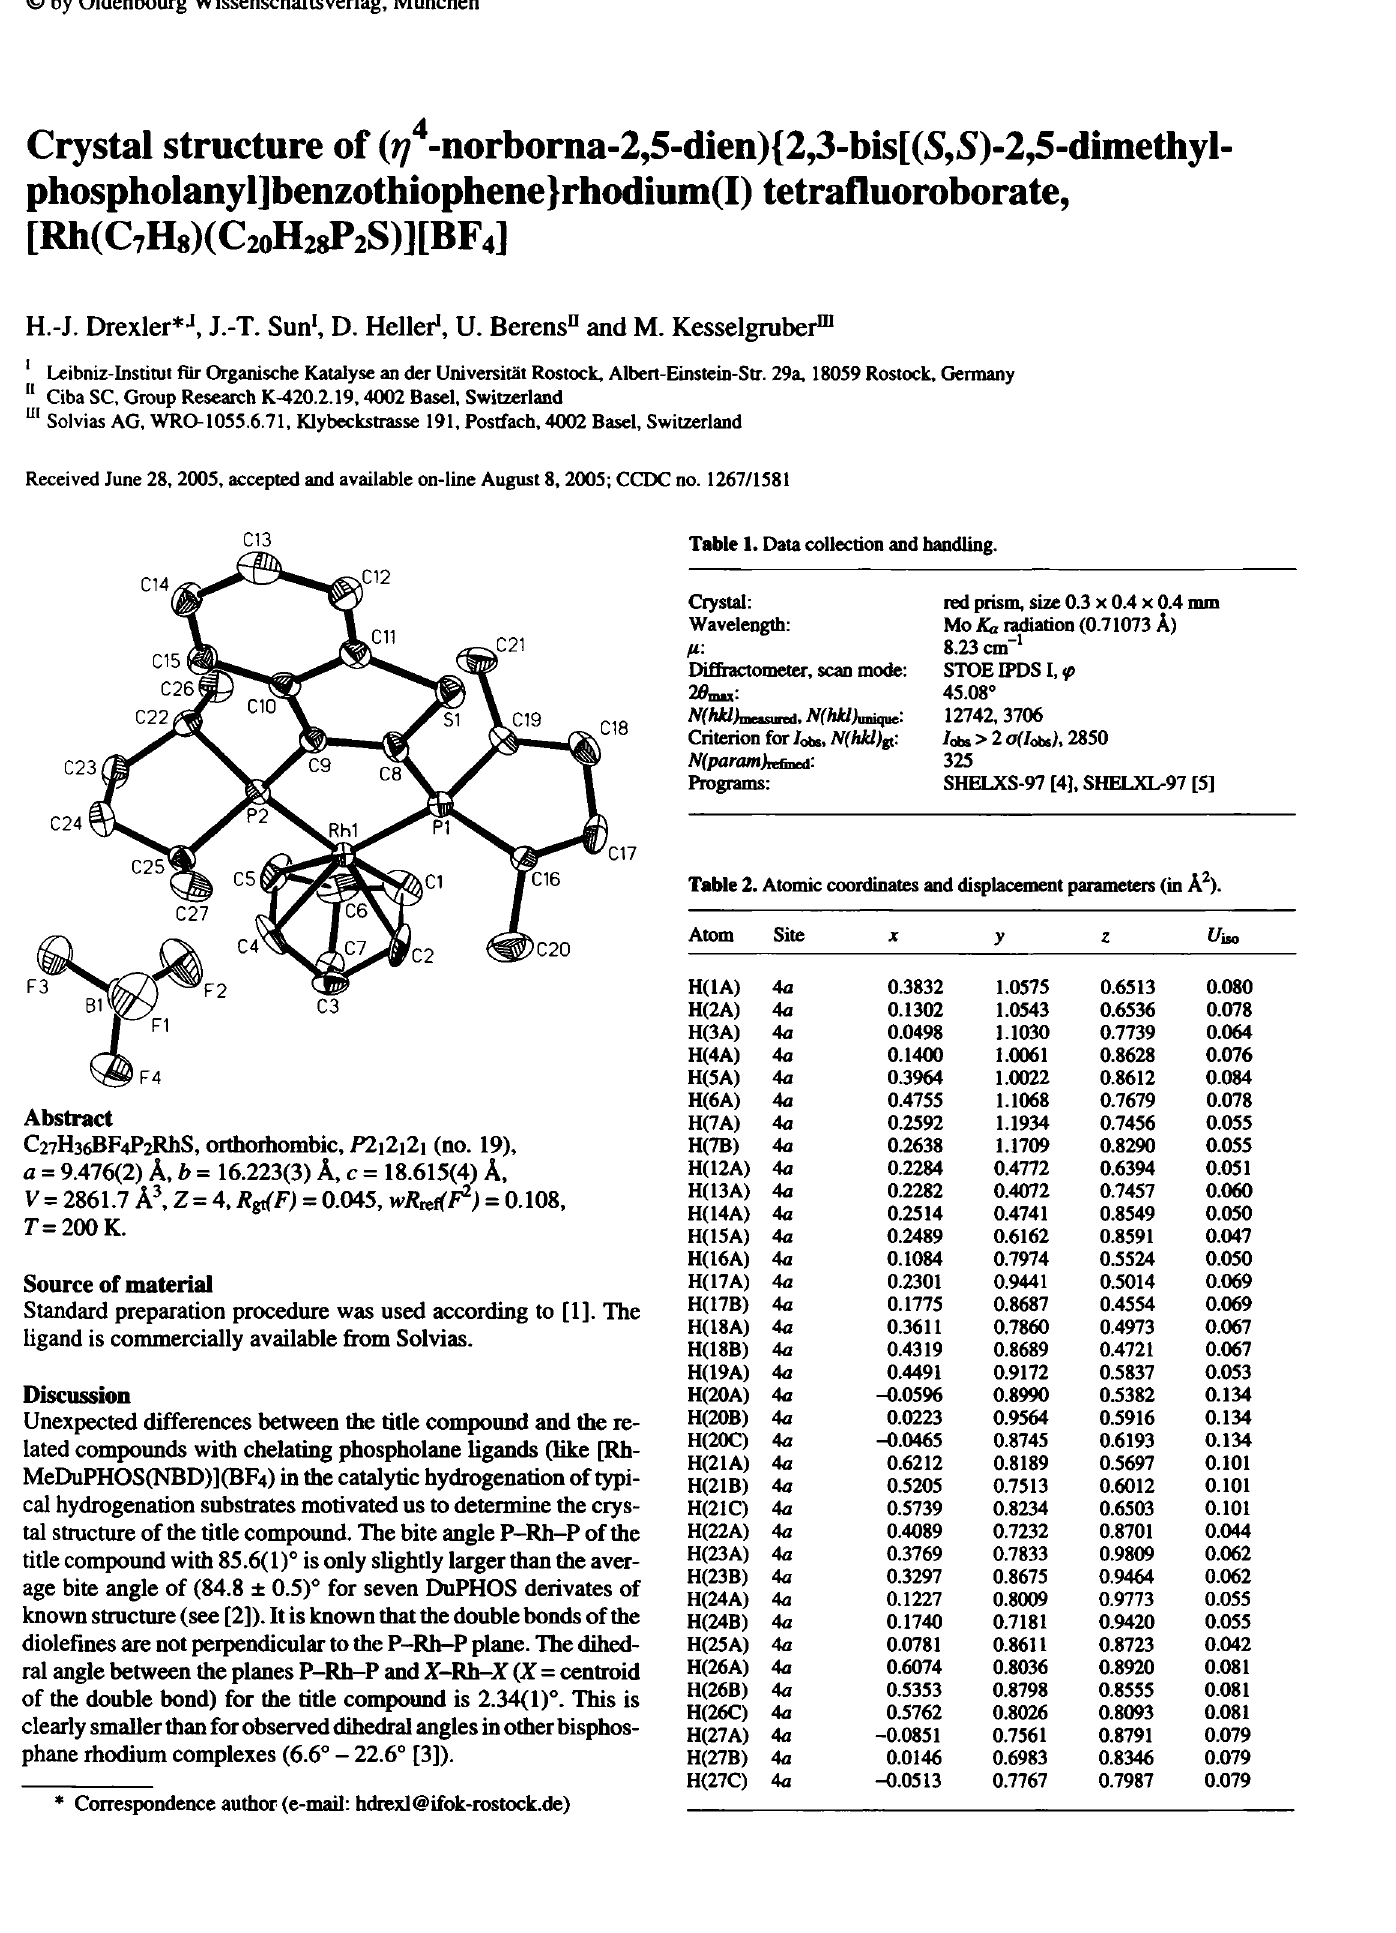
Table 1. Data collection and handling.